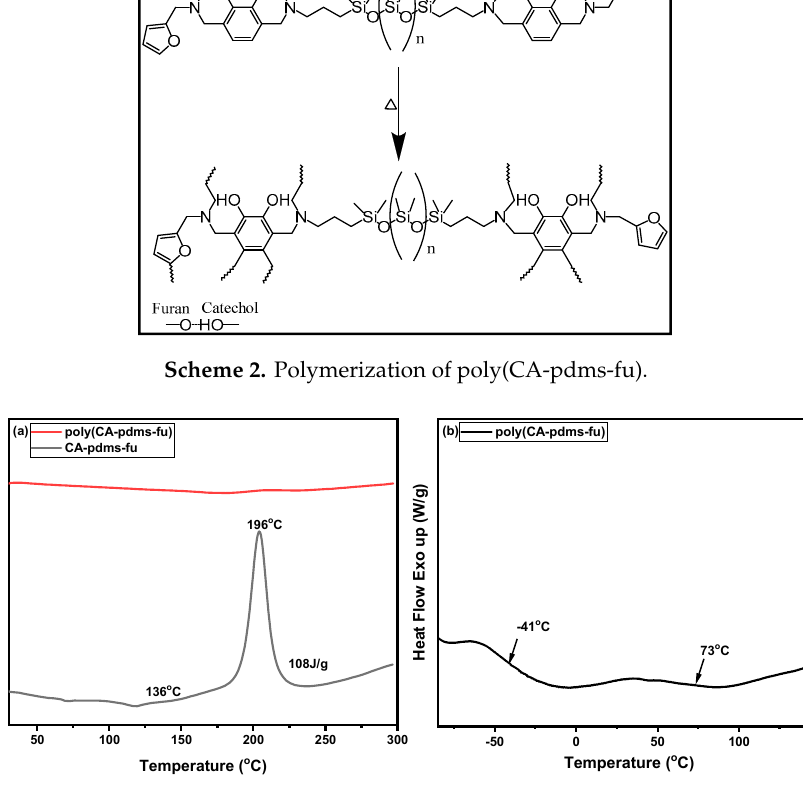
Figure 3. DSC thermograms for ( a ) CA-pdms-fu, lower curve and poly(CA-pdms-fu), upper curve and ( b ) DSC thermogram showing glass transition temperature of poly(CA-pdms-fu).